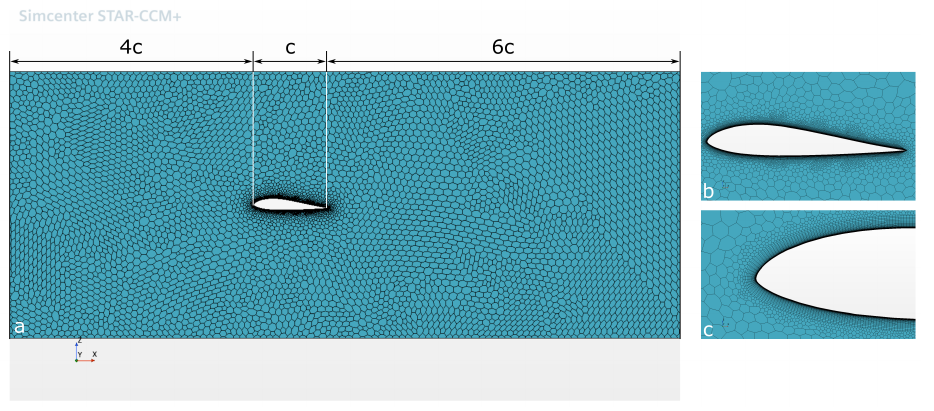
Figure 5. Volume